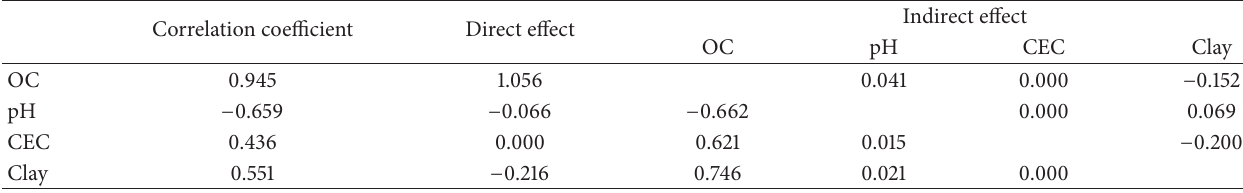
Table 5: Path analysis coefficients to 𝐾 𝑓 of soil factors.